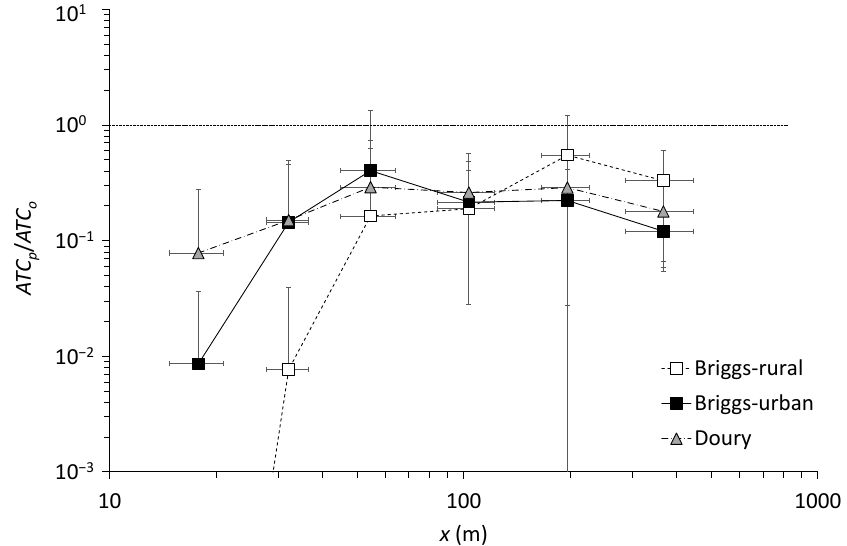
Figure 5. Ratio between the atmospheric transfer coefficients ATC p predicted by the Briggs-rural, Briggs-urban and Doury Gaussian models and ATC o measured as a function of distance x from the discharge point.